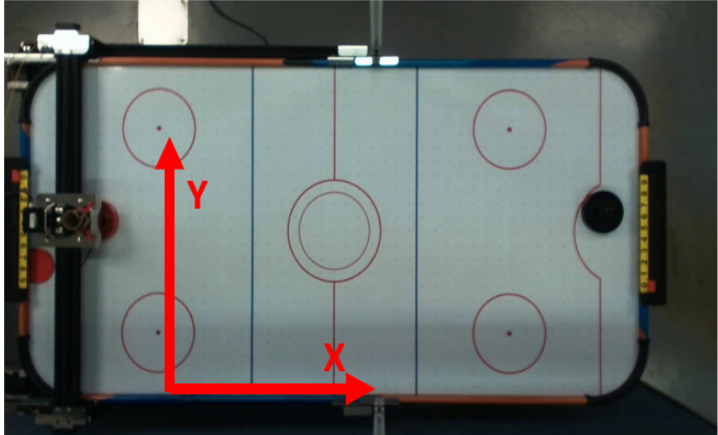
Figure 17. Air hockey table. Table 1. Experimental environment.